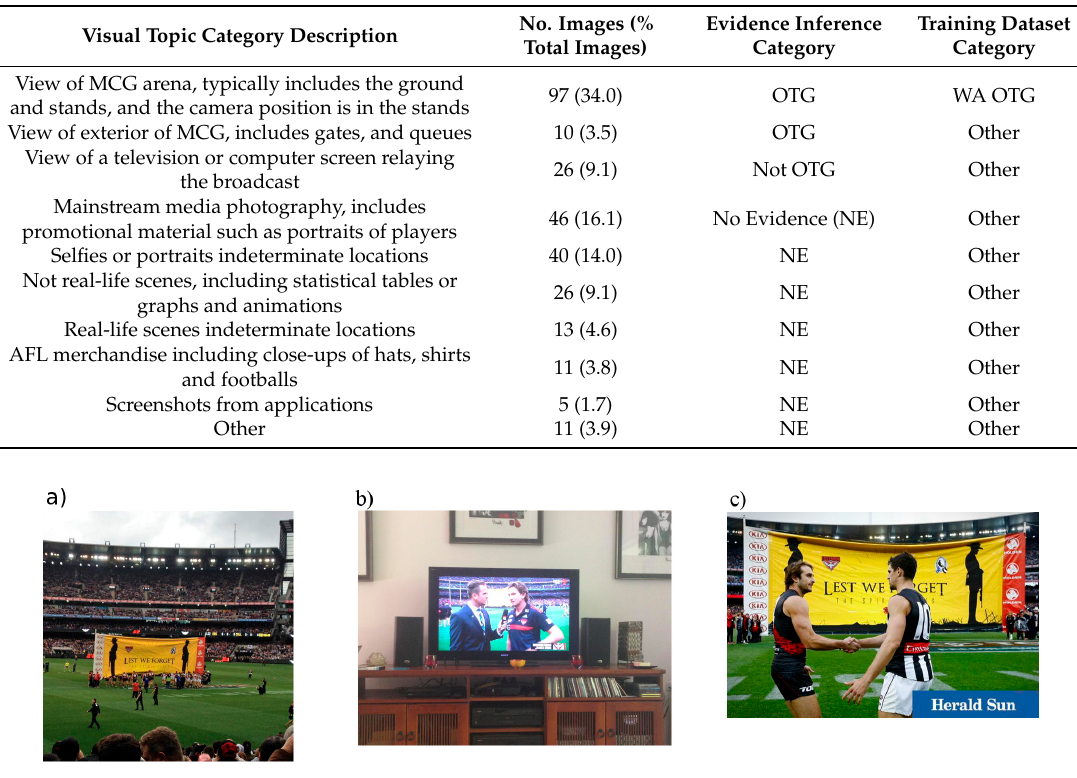
Figure 3. Examples of images categorized as ( a ) the MCG arena or WA OTG [64] ( b ) a screen relaying broadcast [65] and ( c ) media photography [66]. Table 4. The visual topic categories detected in the ADon dataset including their description, summary statistics, evidence inference category, and training dataset category for the binary classification.